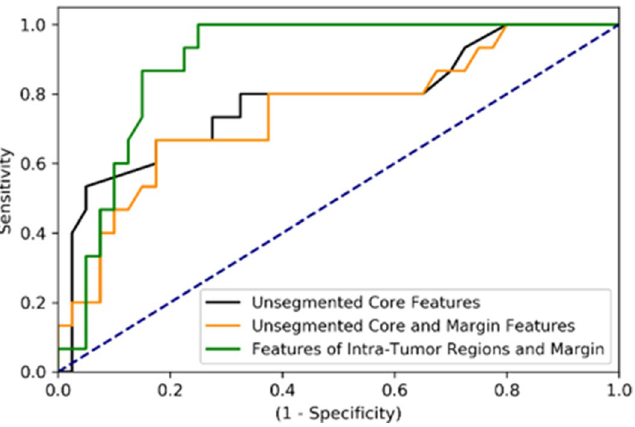
Figure 5. The ROC curves of the therapy response prediction models with different QUS feature sets on the independent test set.